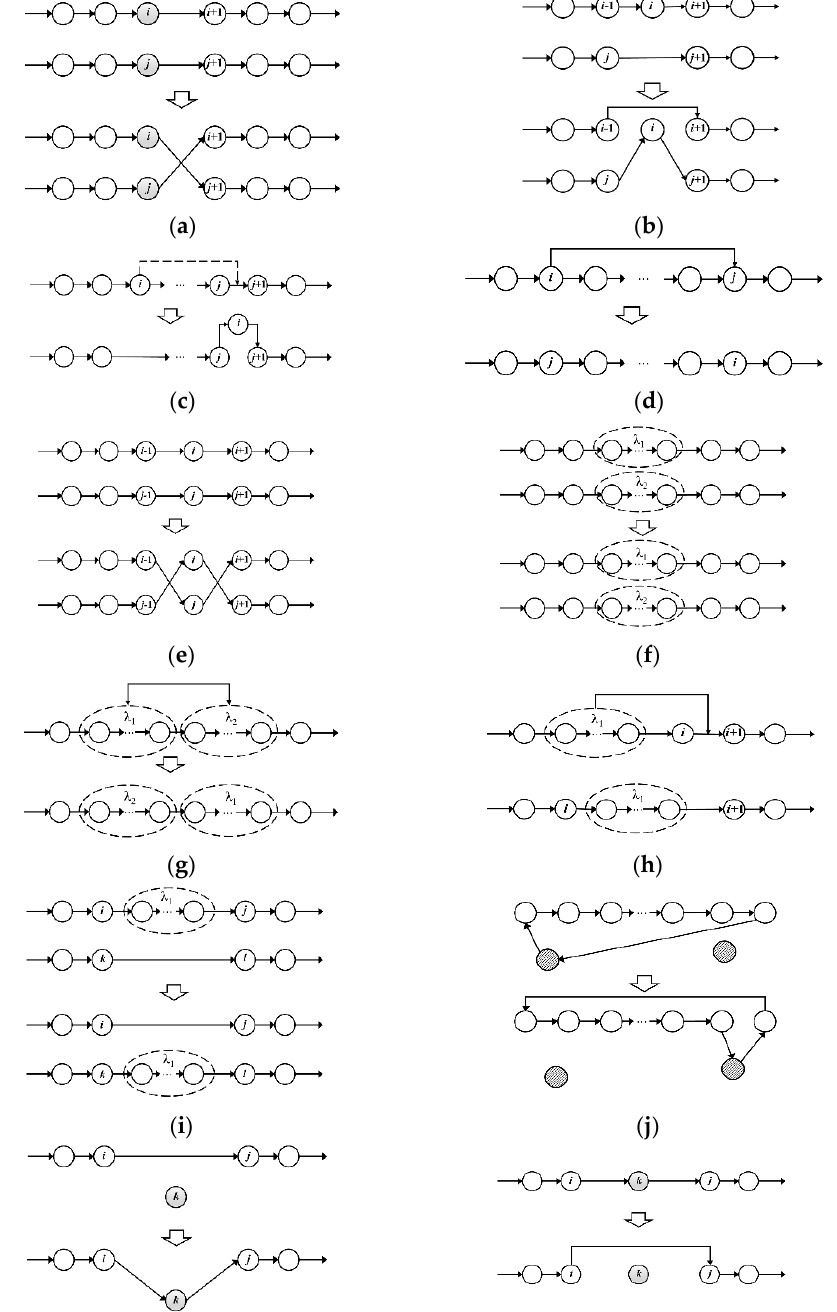
Figure 3. Neighborhoods for the proposed VNS.